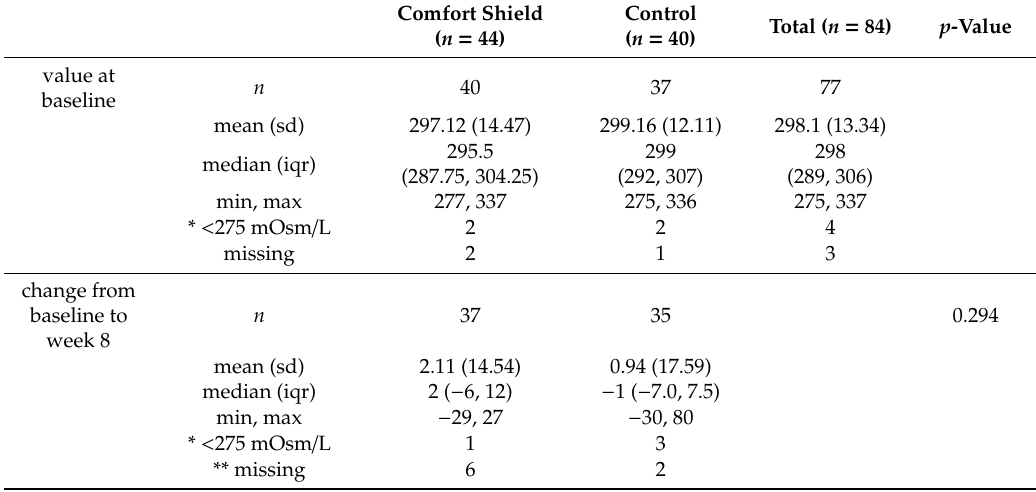
Table A4. Osmolarity: value in mOsm / L at baseline and change from baseline to week 8–PPS ( n = 84)–Descriptive analysis, by treatment arm.